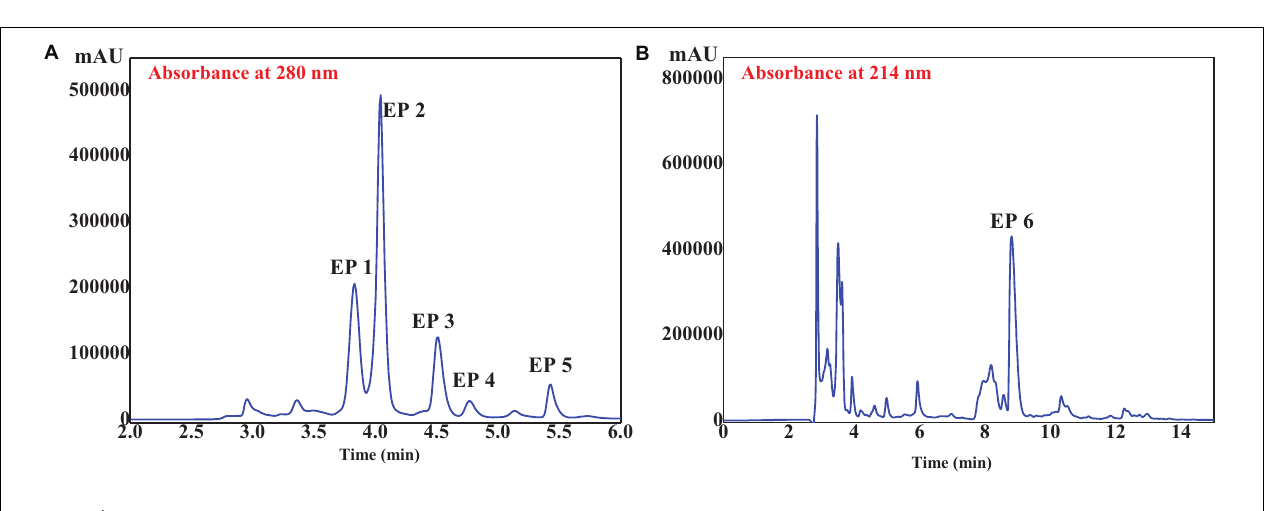
FIGURE 5 | RP-HPLC profile of GD-II on a Zorbax C18 column (4.6 mm × 250 mm, 5 µ m) at 280 (A) and 214 nm (B) wavelength. TABLE 1 | Retention time (R t ), amino acid (AA) sequences, molecular masses, and radical scavenging activities of six antioxidant peptides (EP1-EP6) from E. cottonii